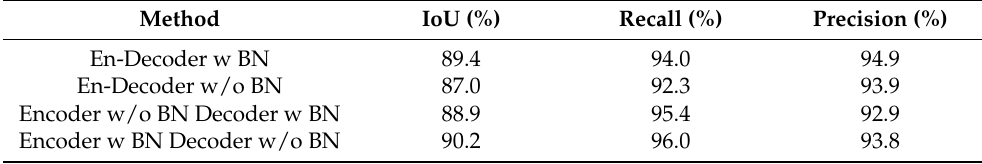
Table 7. Comparison of all the components with or without the BN layer in the encoder or the decoder.